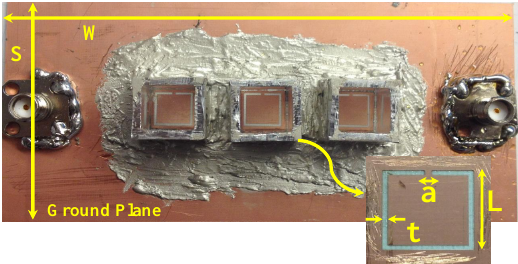
Figure 9. The fabricated MIS system, where L = 7.5 mm, t = a = 0.5 mm, W = 100 mm, and S = 50 mm.